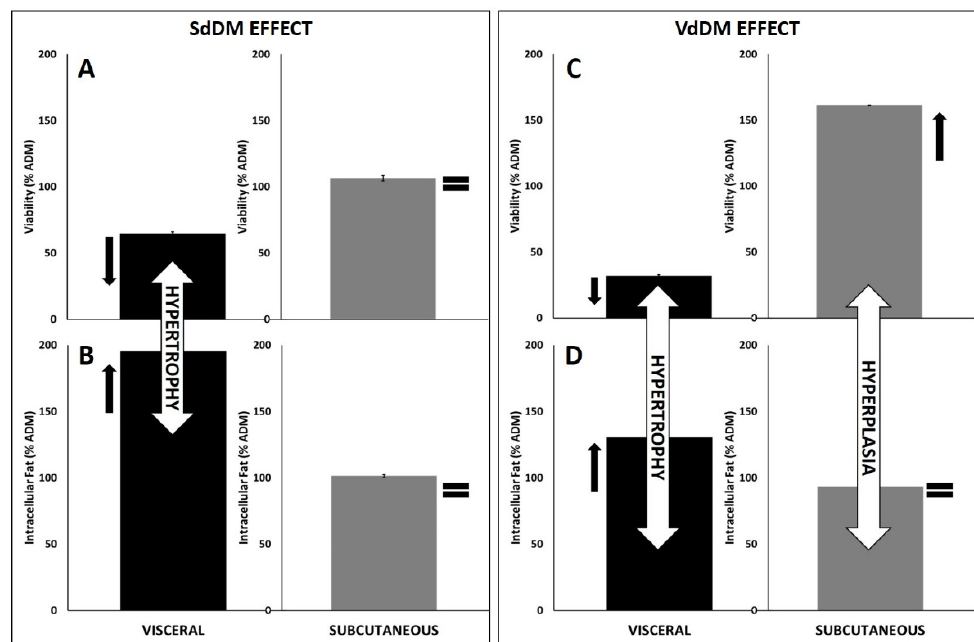
Figure 7. Schematic representation of the pattern effect of secretomes, as seen by juxtaposing viability and intracellular fat of adipocytes. Panel ( A , B ): effect of SdDM on viability and intracellular fat of visceral (left) and subcutaneous (right) adipocytes. Panel ( C , D ): effect of VdDM on viability and intracellular fat of visceral (left) and subcutaneous (right) adipocytes. The “=“ indicates no effect. Black arrows approaching indicate a tendency towards hypertrophic growth. Black arrows moving away indicate a trend towards hyperplasia.